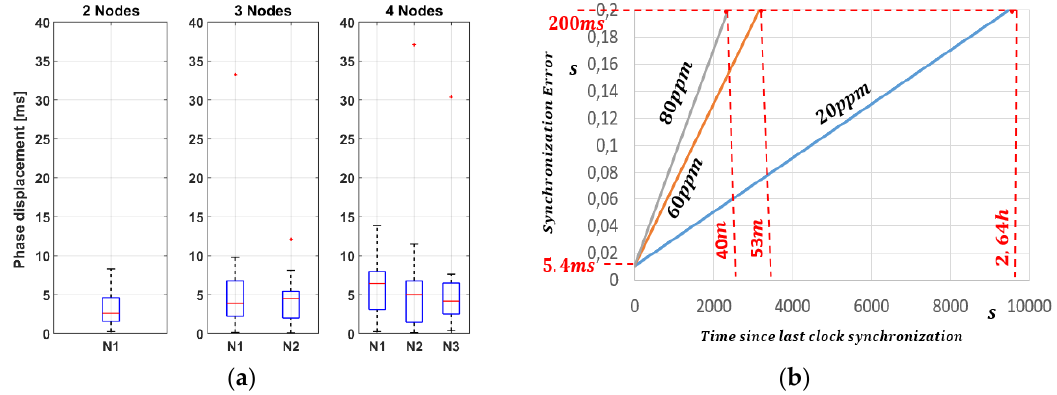
Figure 8. ( a ) Median, 25th, and 75th of synchronization error between 2 – 4 end nodes; ( b ) typical crystal drift over time.